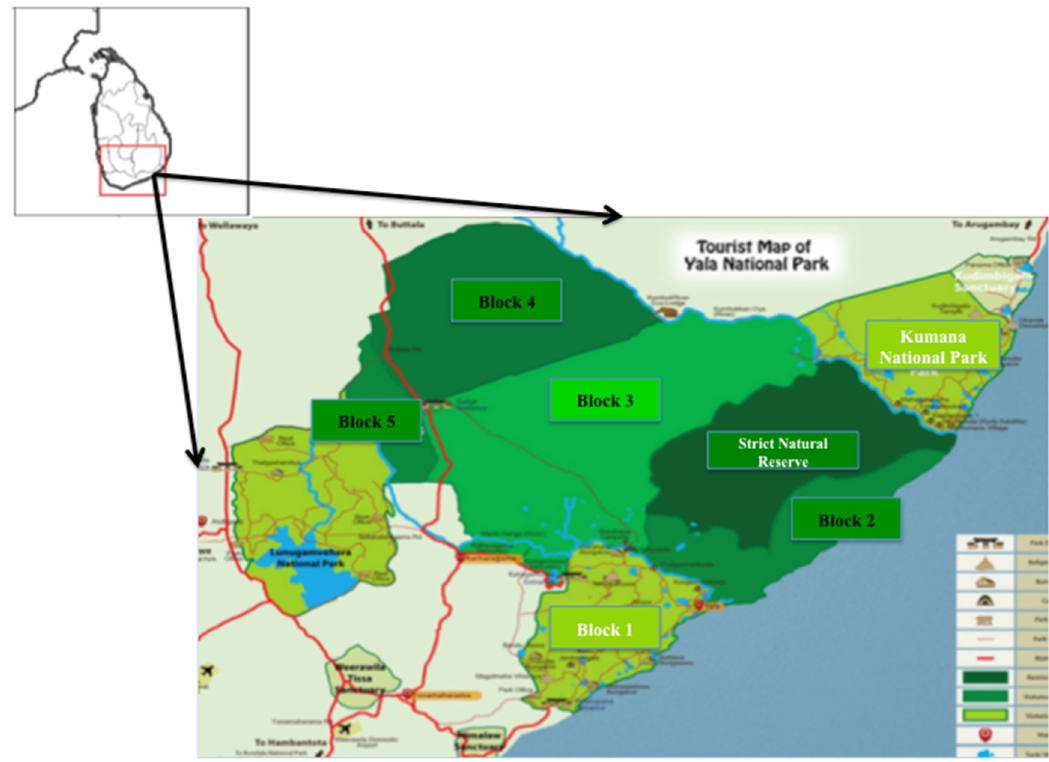
Figure 1. A tourist map of Yala National Park (adapted from the Sri Lankan Wildlife Department). Source: Wildlife conservation department of Sri Lanka .